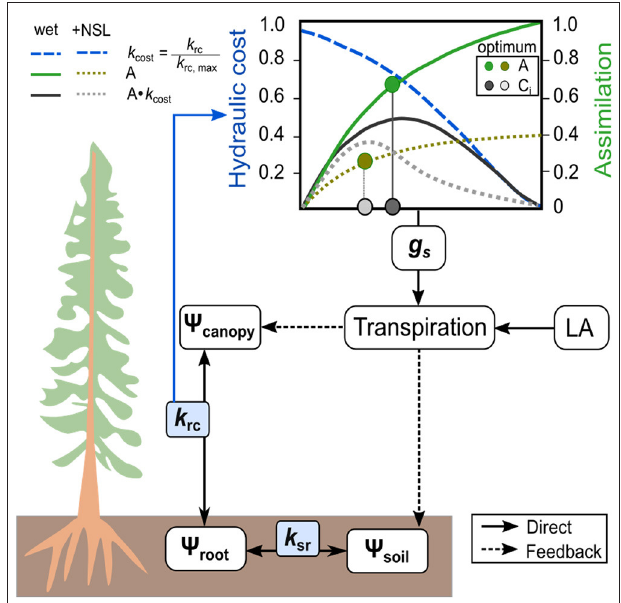
FIGURE 2 | Scheme of the SOX + model. Soil-to-atmosphere is described as a hydraulic pathway considering three nodes: hydraulic flow from soil to the roots, mediated by soil-to-root conductance (k sr ), hydraulic flow from roots to the canopy, mediated by root-to-canopy conductance (k rc ), and hydraulic flow from the canopy to the atmosphere, mediated by stomatal conductance (gs). The optimum gs is determined by considering the photosynthetic gain (A) multiplied by the hydraulic cost function (k cost ), which describes the decreases in k rc as Ψ canopy becomes more negative. Transpiration is calculated at the tree level by multiplying gs and leaf area, and it has a direct effect on canopy water potential, an indirect effect on soil water content, and therefore on Ψ soil . Non-stomatal limitations of photosynthesis (NSL) decrease optimum stomatal conductance because of limiting A when Ψ canopy declines below a predefined